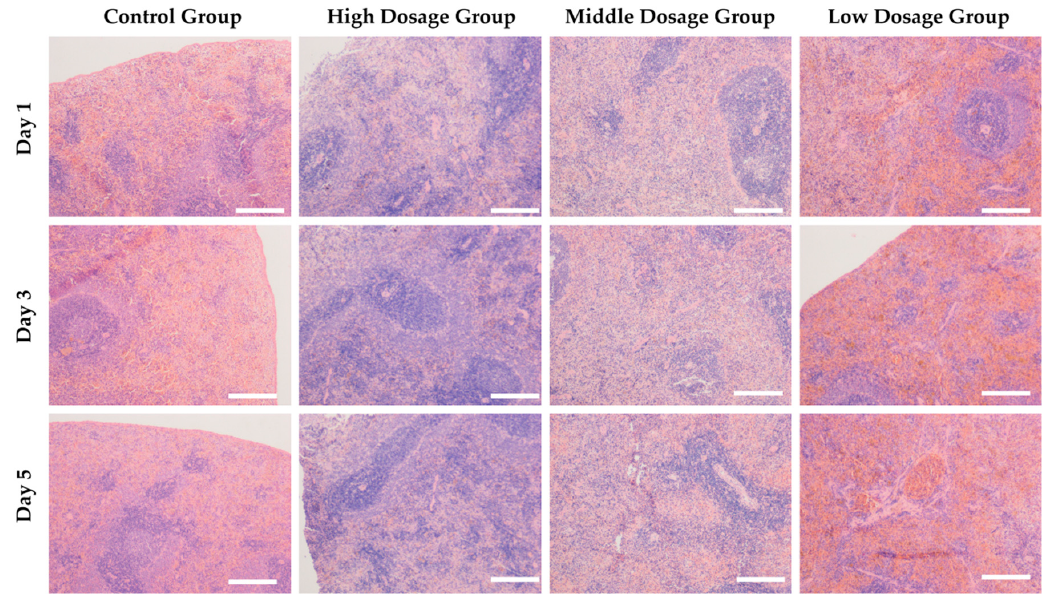
Figure 8. Hematoxylin ‐ eosin (HE) staining of Sprague ‐ Dawley (SD) rat spleen at various indicated days after injecting hydrogels with different drug dosages into the vagina (high dosage, middle dosage, and low dosage). The CP ‐ 3 block copolymer solution at the concentration of 30 wt% was used. The volume of drug ‐ loaded copolymer solution injected into the vagina is 0.2 mL. Copolymer solutions without loading drug were injected into the vagina of SD rats as a control group, scale bar: 20 μ m.